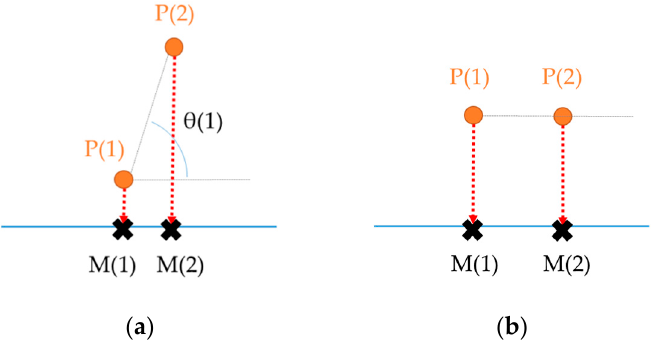
Figure 9. Visual explanations of reliability of a map-matching result: ( a ) unreliable match (cos θ is close to or less than 0); ( b ) reliable match (cos θ is close to 1) for the 2nd point compared with the matching result of the previous point